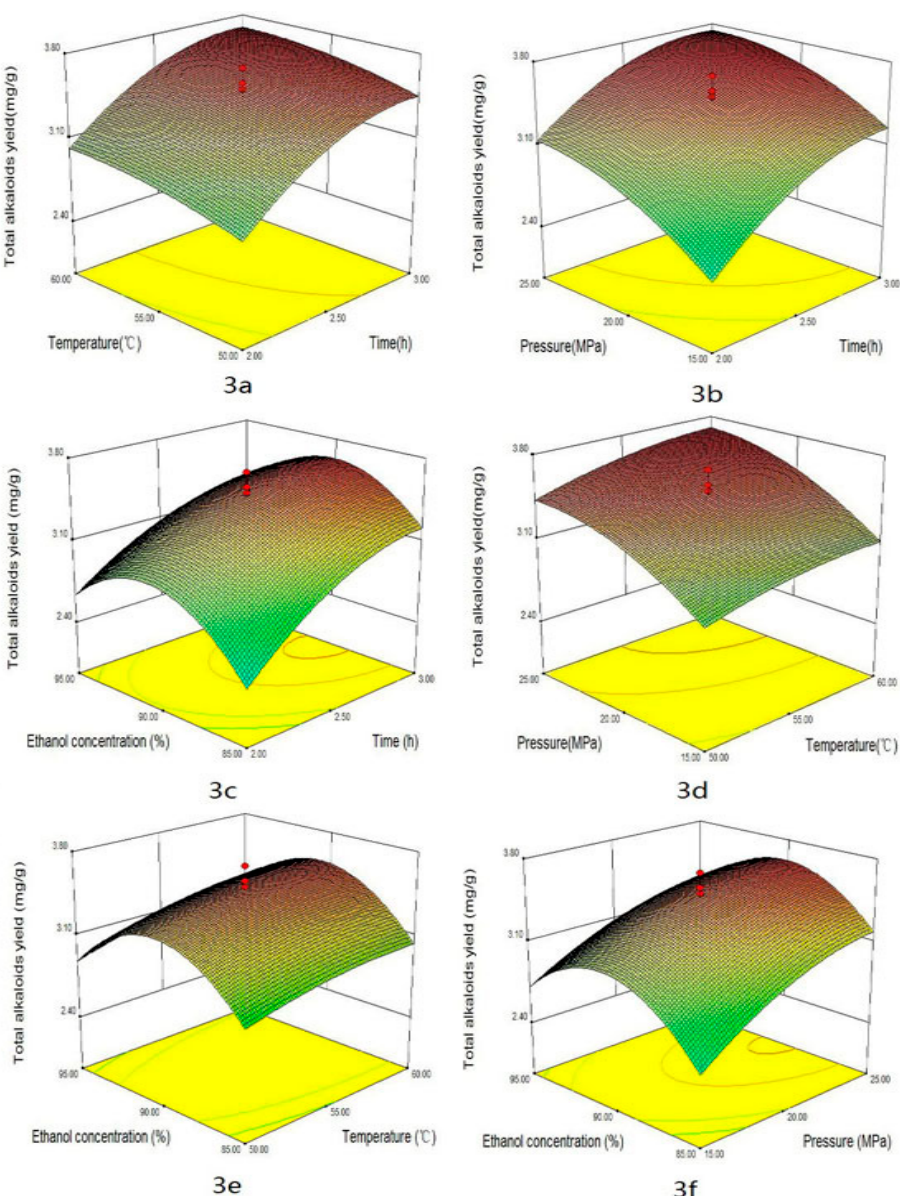
Figure 3. Response surface plots of total alkaloids yields showing: ( a ) the effect of time and temperature at constant pressure (20 MPa) and ethanol concentration (90%); ( b ) the effect of time and pressure at constant temperature (55 °C) and ethanol concentration (90%); ( c ) the effect of time and ethanol concentration at constant temperature (55 °C) and pressure (20 MPa); ( d ) the effect of temperature and pressure at constant time (2.5 h) and ethanol concentration (90%); ( e ) the effect of temperature and ethanol concentration at constant time (2.5 h) and pressure (20 MPa); and ( f ) the effect of pressure and ethanol concentration at constant time (2.5 h) and temperature (55 °C).